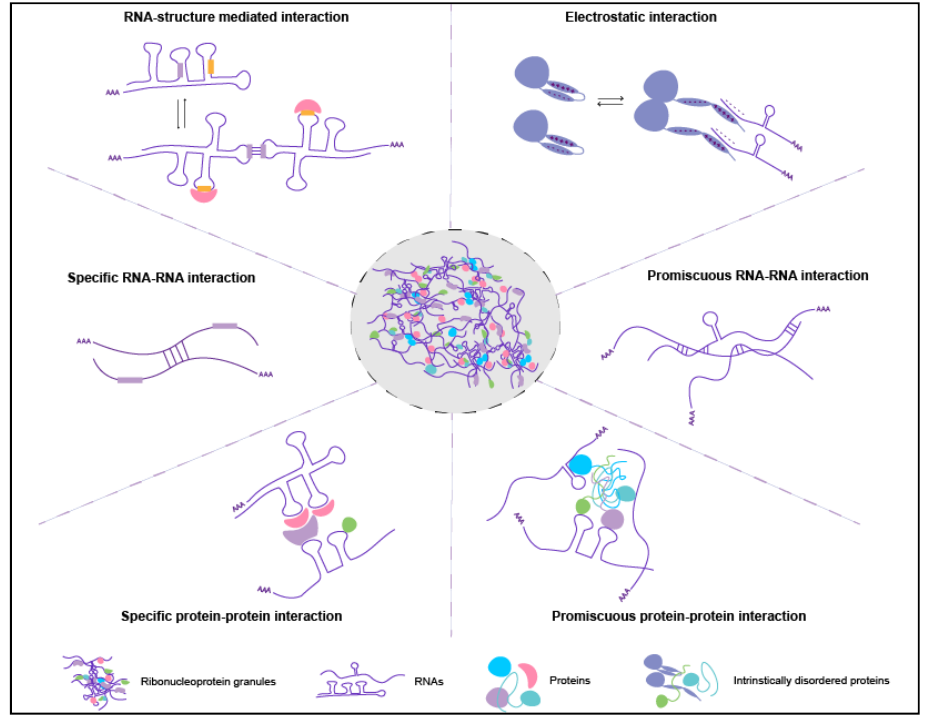
Figure 2. Proposed intermolecular interactions among RNAs and proteins within RNA granules. RNA secondary structures can mask/expose the specific RNA sequences or binding motifs to neighboring RNAs or RBPs. The electrostatic interactions may facilitate RNA-protein interactions in crowded environments, and the proteins can change the conformations when the RNA binds. In addition, intermolecular RNA-RNA and protein-protein interactions can be specific or promiscuous. Intermolecular RNA-RNA and RNA-protein interactions depicted in this model were mostly studied on mRNAs, however similar principles may apply to other RNAs enriched in RNA granules such as piRNAs, microRNAs, or lncRNAs.